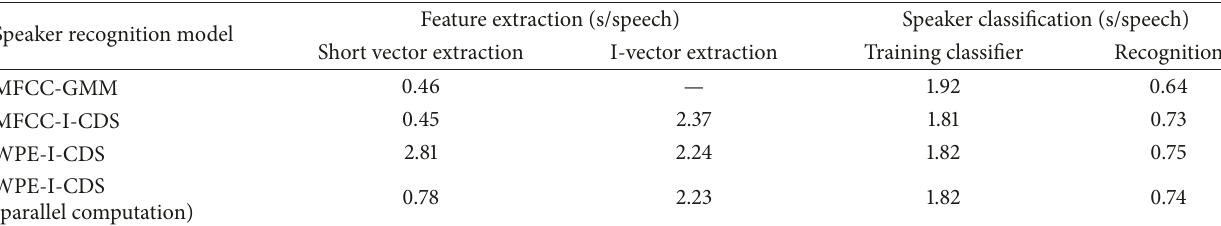
Table 2: The time cost of the different speaker recognition